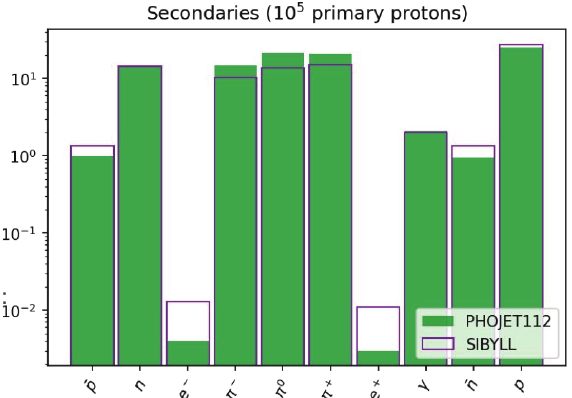
Figure 4. Percentage of particles produced in p-p interactions according to two di ff erent hadronic interaction model: PHOJET [16] and SIBYLL [7]. Credits: L.